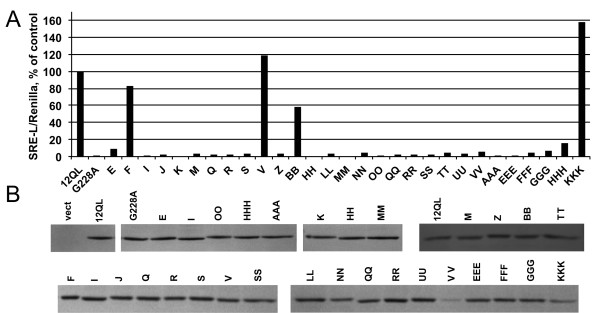
Activation of serum response element mediated transcription by Gα12 mutants. (A) Luciferase reporter assay results of selected cassette mutants. HEK293 cells grown in 12-well plates were co-transfected with the plasmids SRE-L (0.2 μg) and pRL-TK (0.02 μg), plus 1.0 μg of the plasmid encoding each cassette mutant indicated on the X-axis. Firefly luciferase values were normalized for Renilla luciferase values within each sample, and values are presented as a percent of the value calculated for myc-Gα12QL (Y-axis) within the same experiment. Mutationally active (12QL) and inactive (G228A) samples were analyzed in parallel. Results shown are a representative of two experiments performed per Gα12 variant. (B) Expression level of Gα12 mutants. A sample of each lysate was set aside prior to luminometry and analyzed by SDS-PAGE and immunoblotting using anti-Gα12 antibody (Santa Cruz Biotechnology). For all samples, densitometric intensity was determined as described in Methods, then divided by positive control myc-Gα12QL levels within the same experiment, and SRE-L/Renilla values were adjusted to reflect this normalization for protein levels.